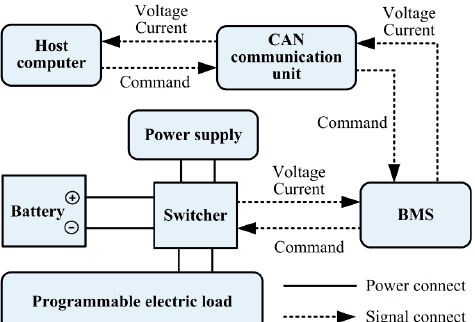
Figure 4. Configuration of battery test bench. CAN: controller area network; and BMS: battery management system.